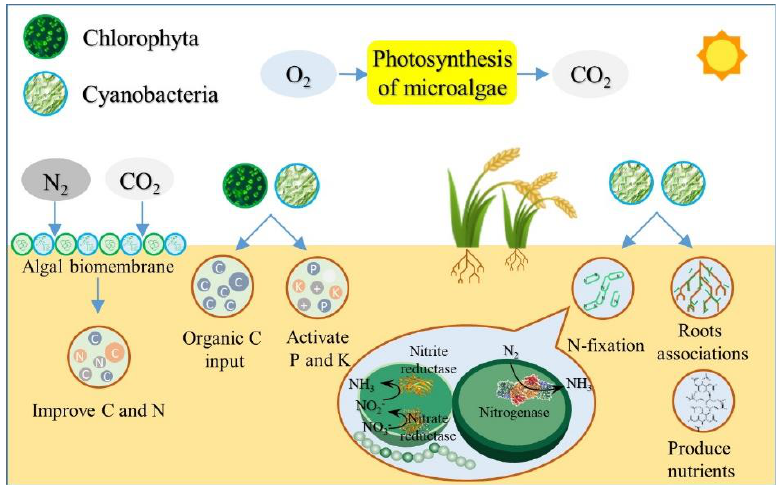
Figure 3. Beneficial effects of microalgae on soil and GHG emissions.